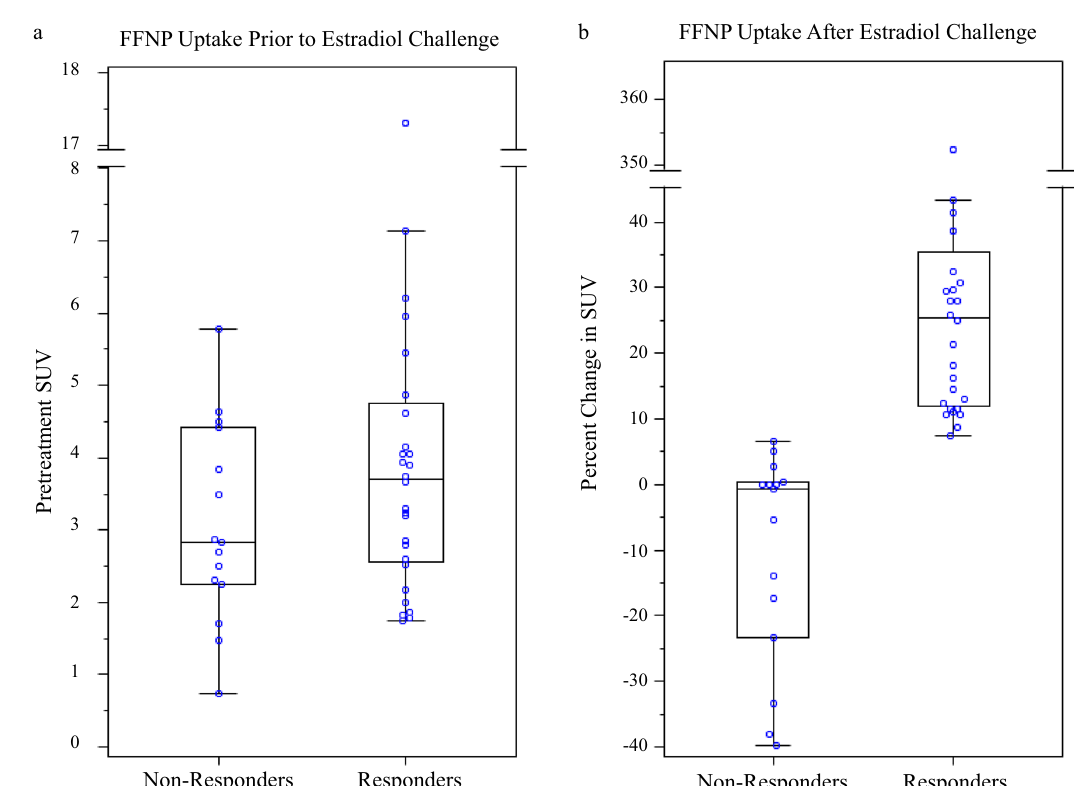
Fig. 3 Tumor FFNP uptake in responders and nonresponders. a Baseline SUV, b Percent change in SUV after estradiol